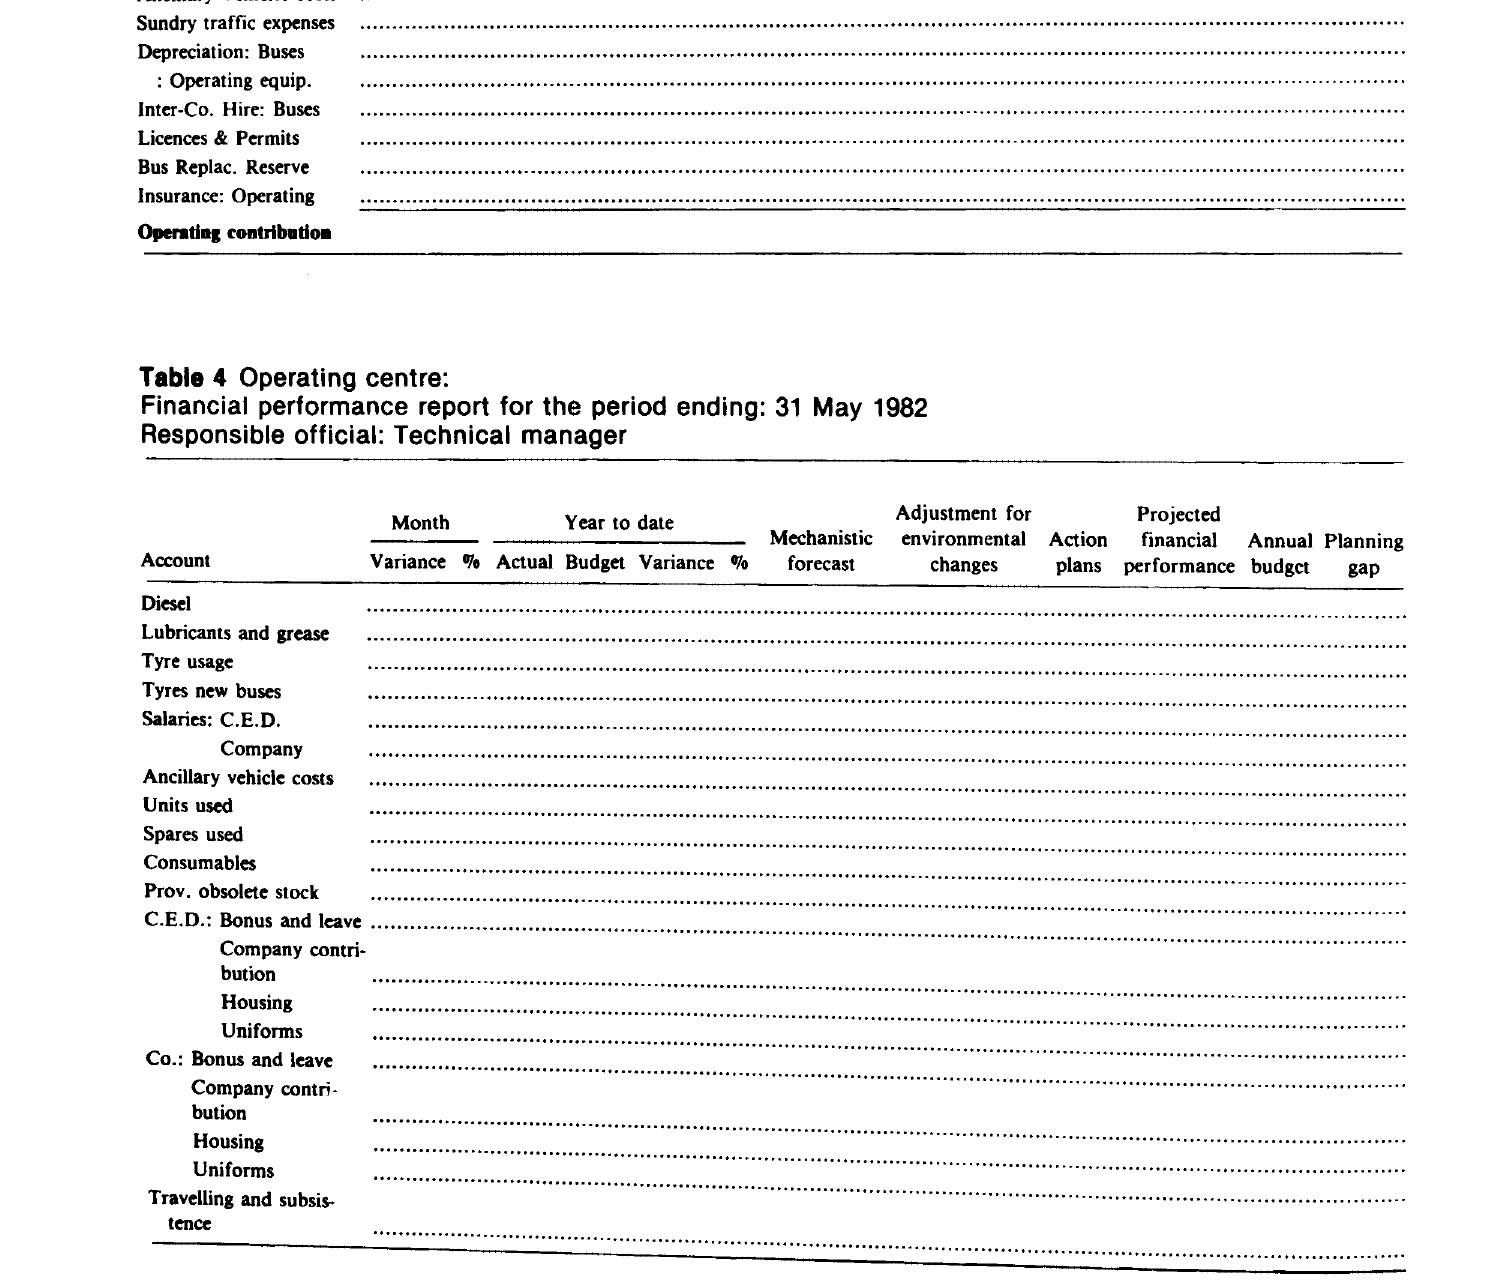
Table 4 Operating centre: Financial performance report for the period ending: 31 May 1982 Responsible official: Technical